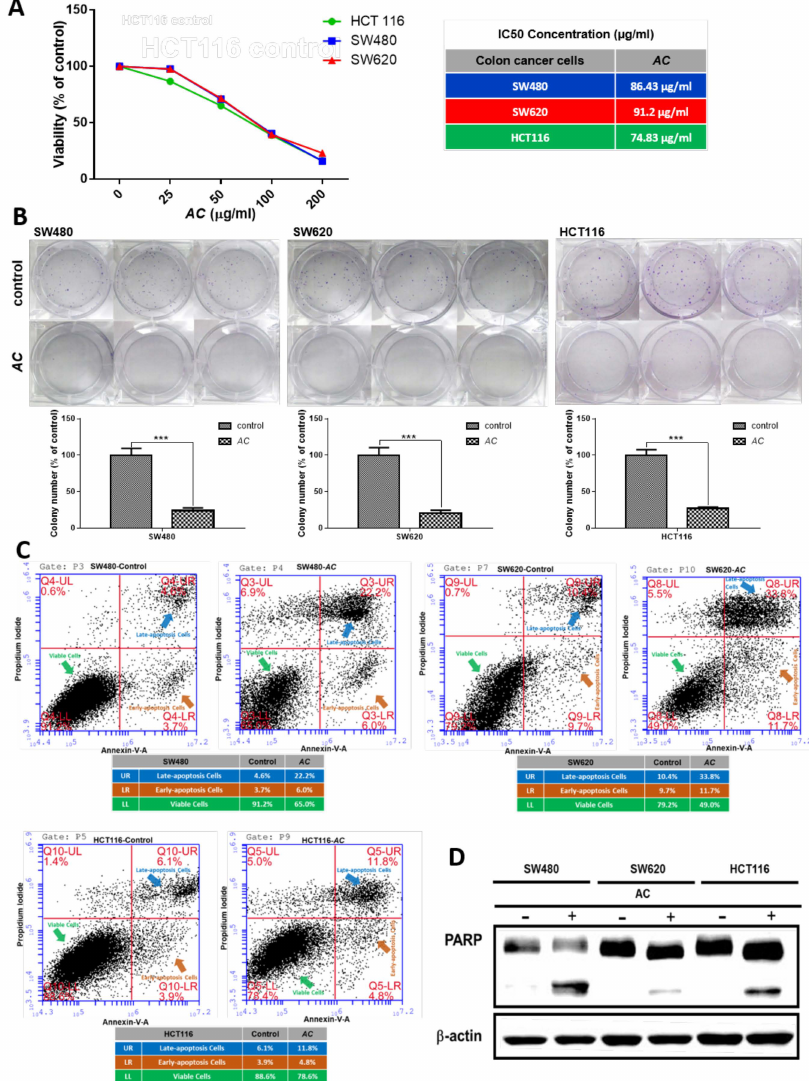
Figure 1. AC treatment decreases the viability of CRC cells by inducing apoptosis. ( A ) Cell viability assay demonstrates that AC is e ff ectively suppressing the cellular viability in CRC cells. The IC50 values of AC in all three cells (SW480, SW620 and HCT116) are indicated. ( B ) AC e ff ectively suppresses colony-forming ability. *** p < 0.001. ( C ) Colon cancer cell lines were treated with AC (100 µ g / mL) for 24 h and then analyzed for apoptosis by flow cytometer for Annexin-V + and PI + stained cells. AC significantly induces apoptosis in CRC cells (SW480, SW620 and HCT116). Number in the box indicates the percentage of Annexin-V + cells (control versus AC treatment, left and right respectively). ( D ) Western blots of the whole-cell lysates from AC treated colon cancer cells showed a significantly increased level of cleaved PARP (pro-apoptotic